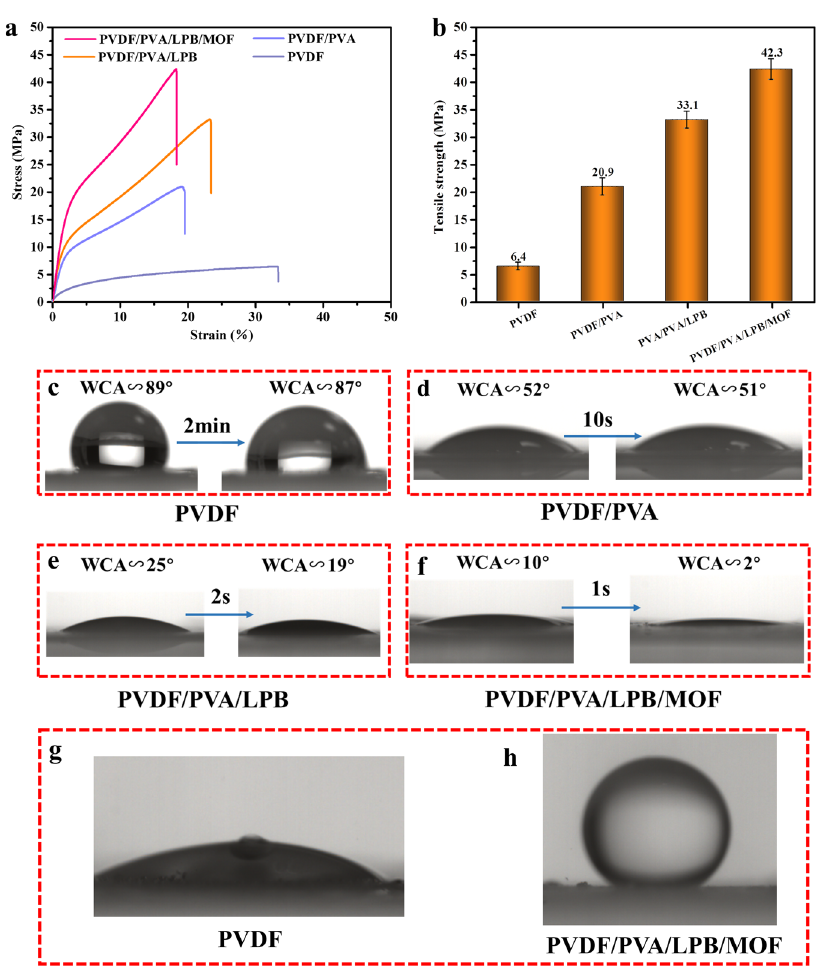
Fig. 3 Mechanical properties and hydrophilicity of different composite fi lms. a The stress-strain diagram of different hybrid membranes. b The tensile strength of different hybrid membranes. The change of contact angle (WCA) of c PVDF (s.d.), d PVDF/PVA, e PVDF/PVA/LPB and f PVDF/PVA/LPB/MOF fi lm in different time. Underwater oleophobicity of g PVDF and h PVDF/PVA/LPB/MOF